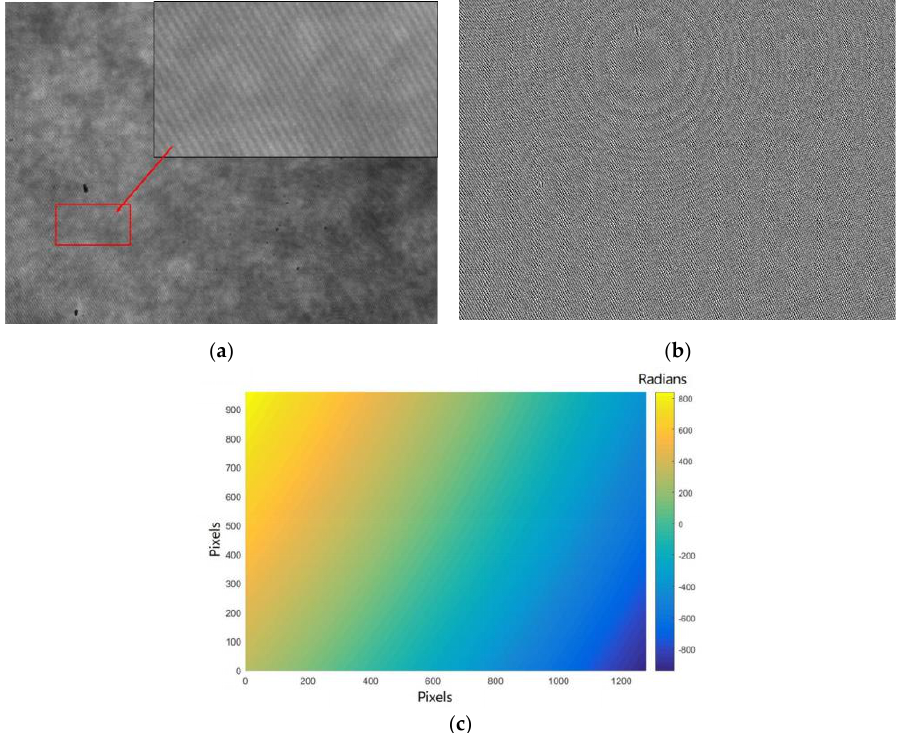
Figure 4. Reconstructed phase data for the basal plate, including ( a ) the hologram, ( b ) the wrapped phase map, and ( c ) the unwrapped phase map.